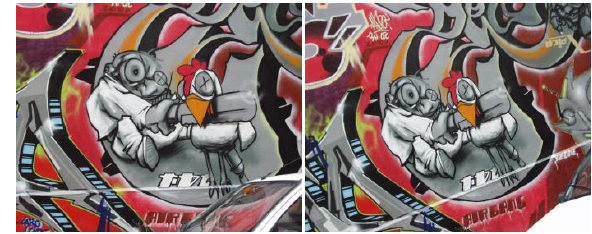
Figure 4. One test image pair from "graf" datasets.